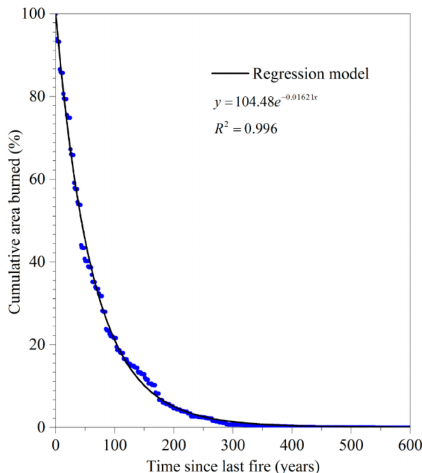
Figure 5. The cumulative TSLF distribution and regression model created for the 2100 × 2100 grid simulated landscape using all 1200 fire-year maps. The FC MA estimate from the slope is 61.7 years.